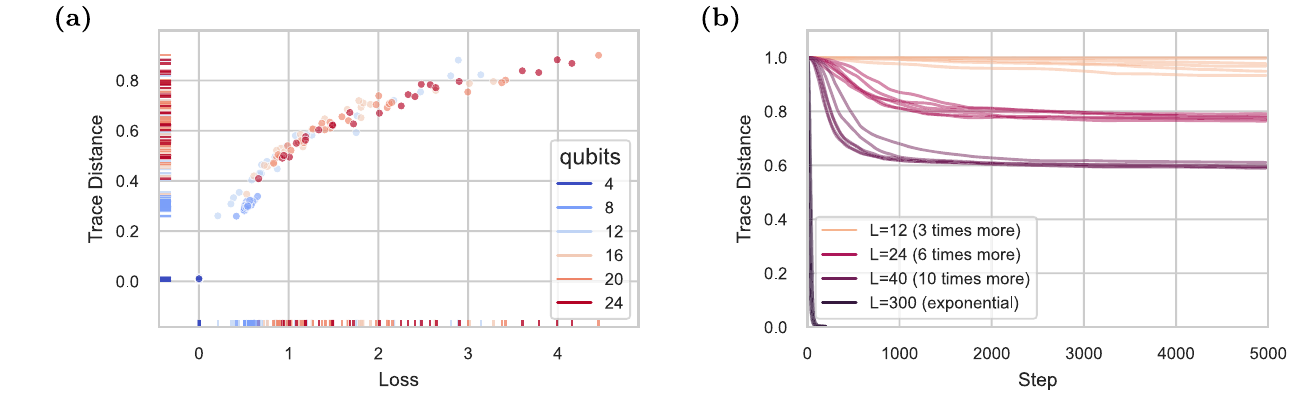
ground state empirically grows exponentially with the number of qubits. Here, we consider4-layerHamiltoniansoftheformof(13)on14qubitswherethenumberof layers L in the ansatz is varied. When the ansatz has 300 layers — enough that the numberofansatzparametersislargerthantheexploredHilbertspacedimension — the model successfully converges to the ground state, rather thanremaining stuck in a poor local